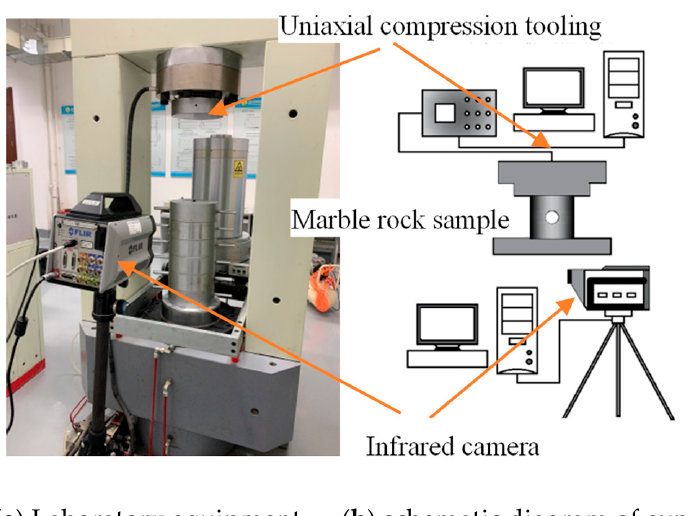
Figure 2. Test system for deep rock gas escape under Temperature-Pressure coupling condition.